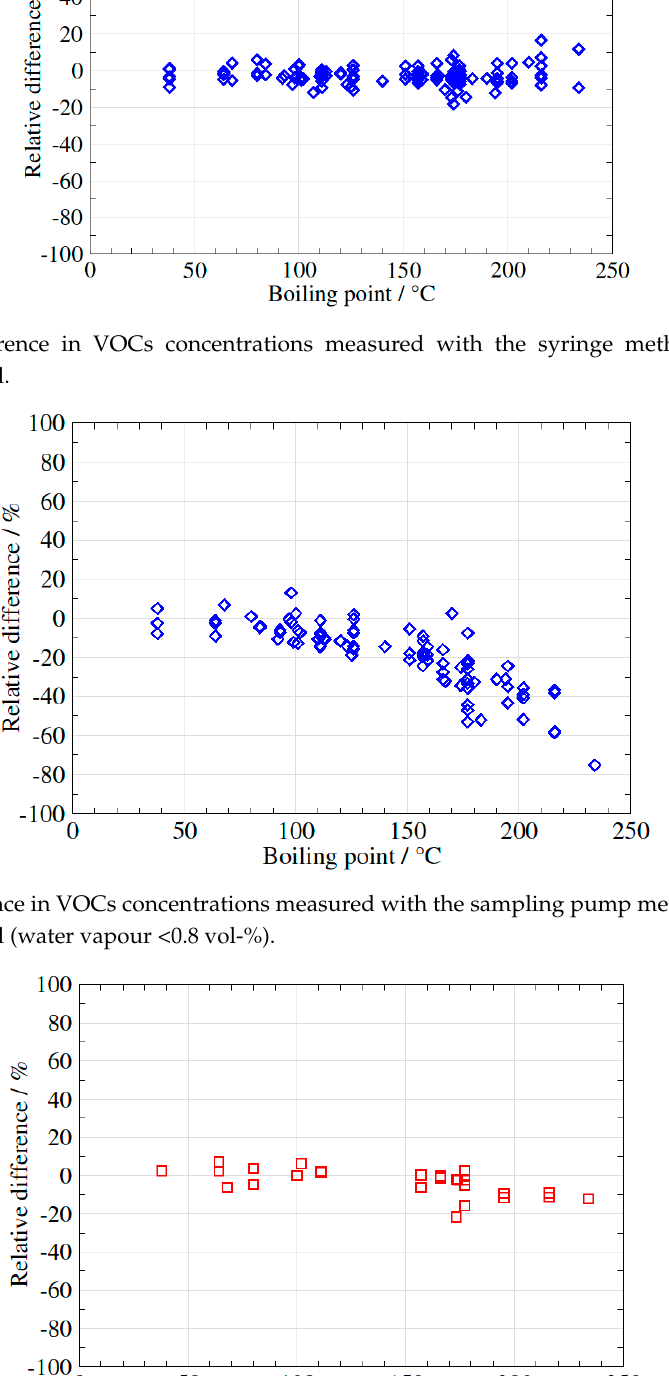
Figure 8. Difference in VOCs concentrations measured with the sampling pump method versus the EasyVOC method (water vapour >0.8 vol-%). EasyVOC method (water vapour >0.8